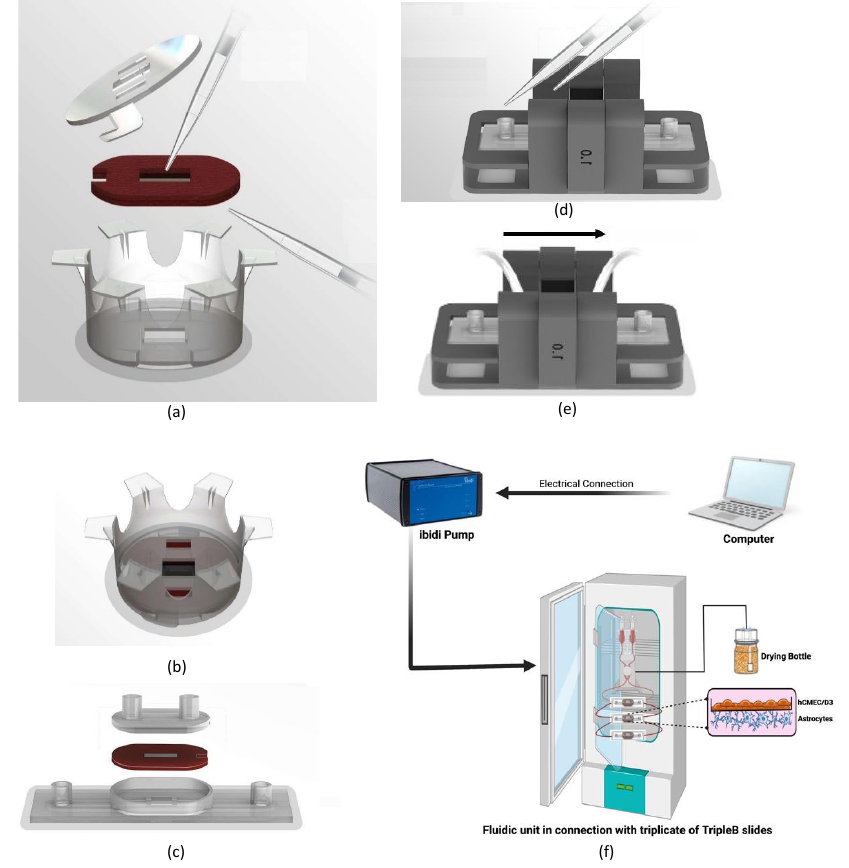
Figure 3. The clinical user flow of the TripleB model. Firstly ( a ) the red-colored removable membrane is seeded using pipettes with poly-L-lysine and endothelial cells on the upper half of the